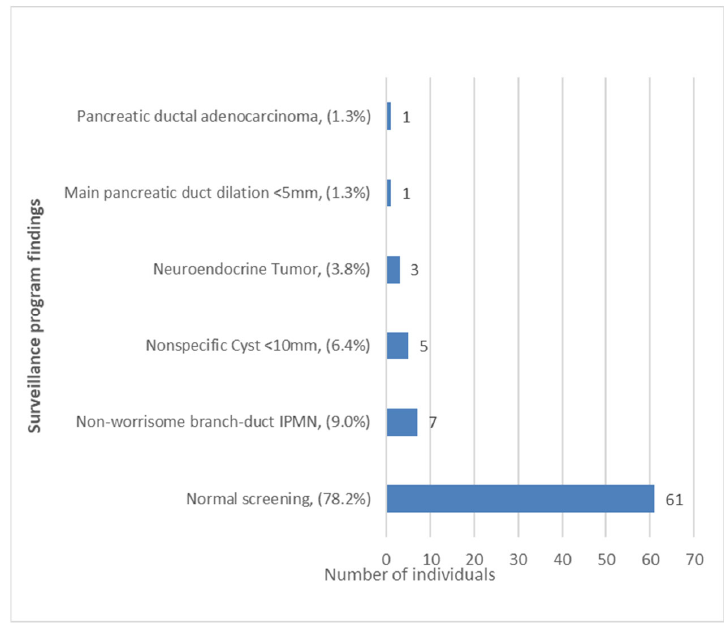
Figure 2. Surveillance findings. IPMN, intraductal papillary mucinous